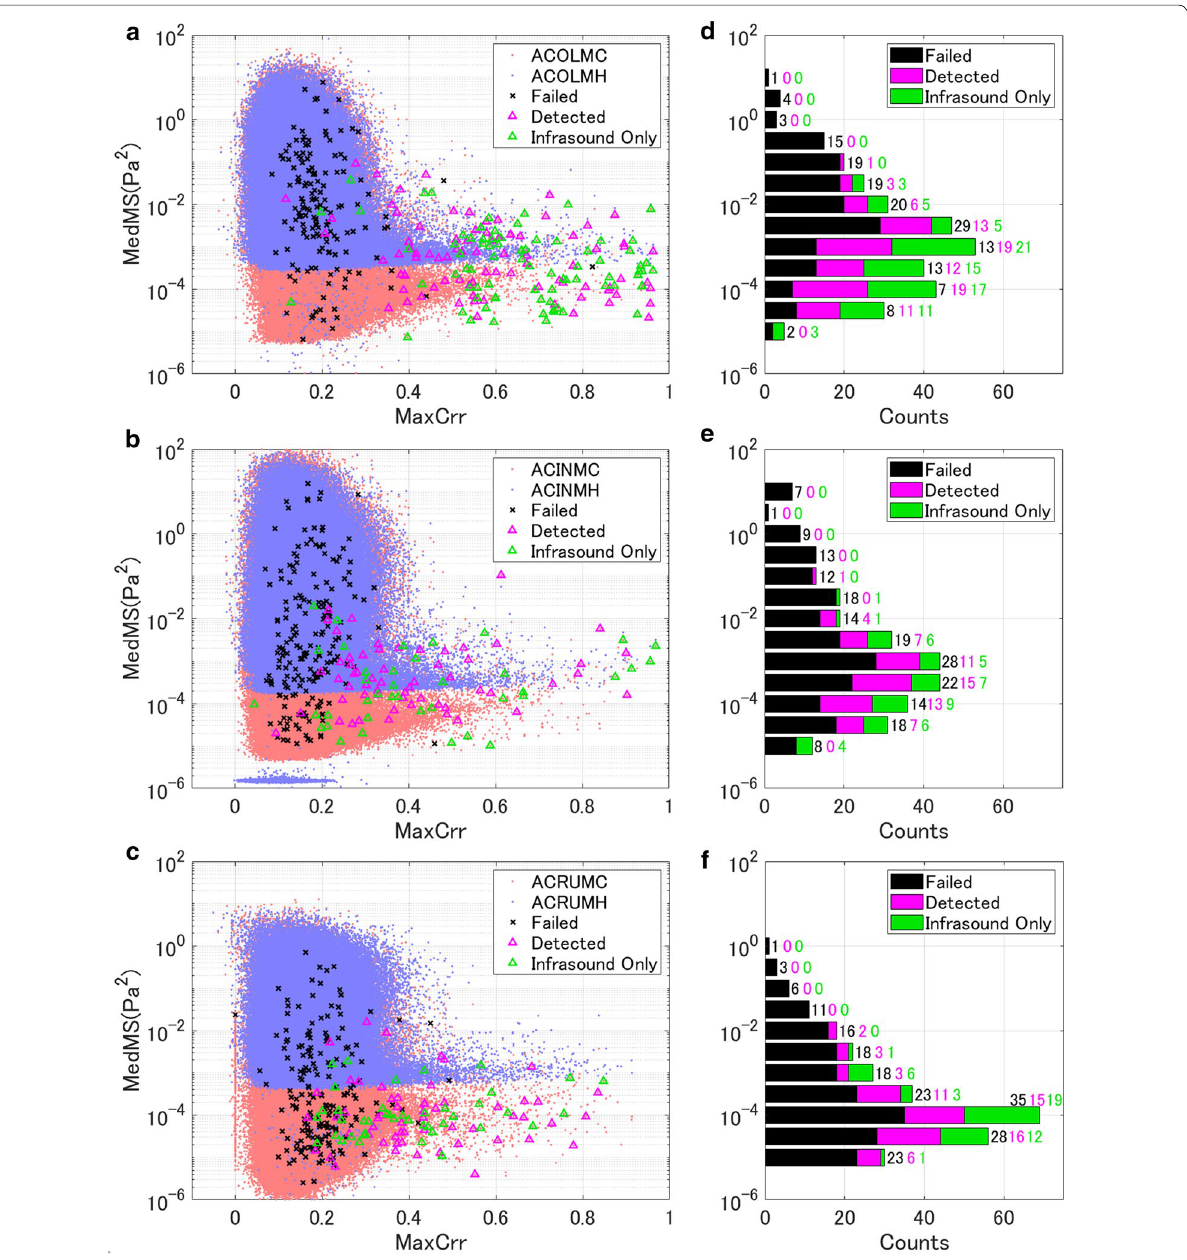
Fig. 6 a – c The maximum cross‑correlation coefficient (MaxCrr) and the median of the mean square (MedMS) in 200‑s long time windows. Coral and medium purple dots correspond to the data from the Chaparral sensor (C) and the Hakusan sensor (H), respectively. On the values of the Chaparral sensors in the time windows corresponding to the reported eruption event times, whether infrasound detection is failed or successful by the black crosses (failed) and the magenta triangles (detected), respectively. The green triangles indicate the eruptions which have not been confirmed by cameras or reports. d – f Histograms of the events for MedMS. The reported events without and with infrasound detection and the infrasound signals without eruption reports are distinguished by black, magenta, and green colors. The individual counts are shown with the colored numbers besides the bars. The failed case counts only the events with the ash plume heights larger than 200 m. Results are shown for ACOLM ( a , d ), ACINM ( b , e ), and ACRUM ( c , f